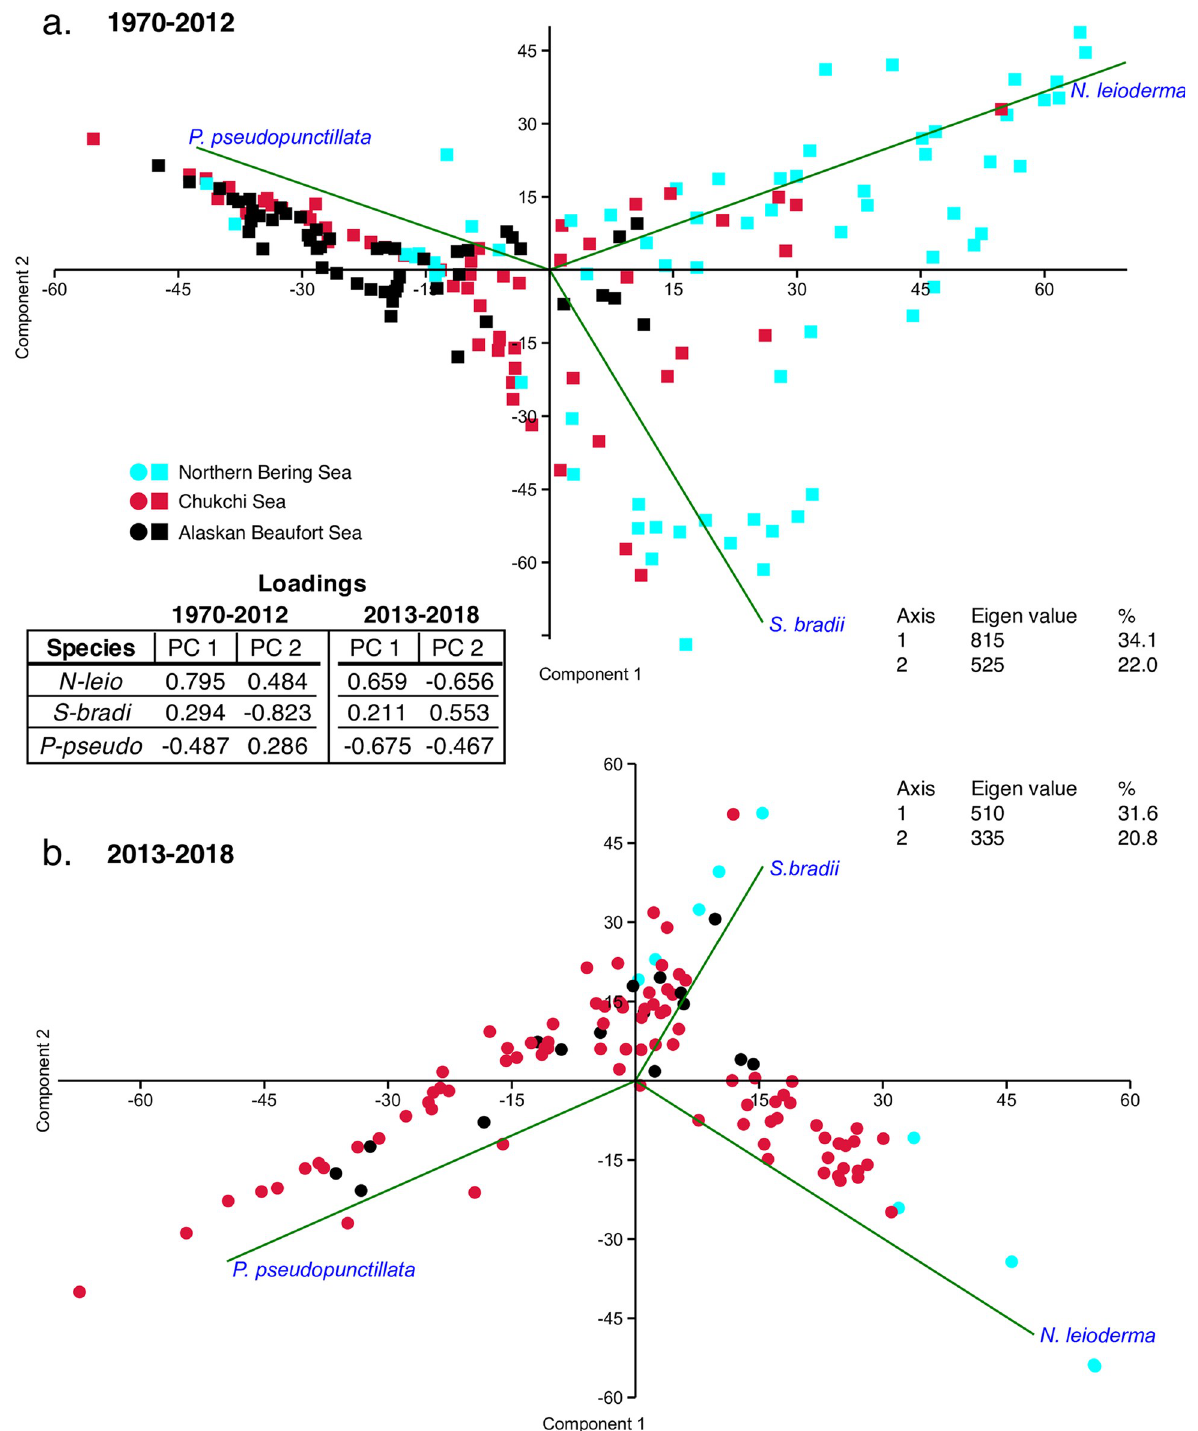
Fig 14. Principal correspondence analysis of ostracode assemblages by year groups. Synoptic PCAs using the biogeographic dataset (samples located on Fig 1 map) from the BCB grouped by the three regions and two collection periods, a.) 1970–2012 and b.) 2013–2018.